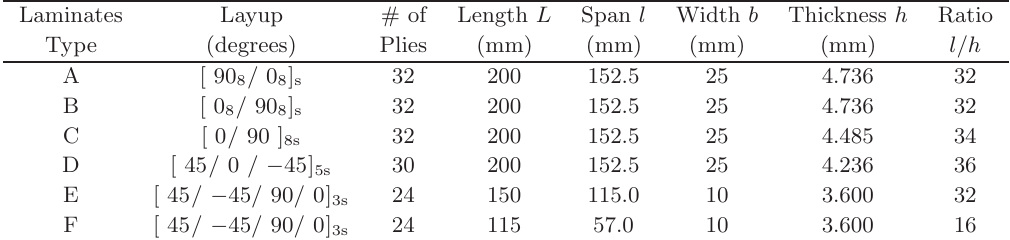
Table 2. Specimen characteristics and specifications.